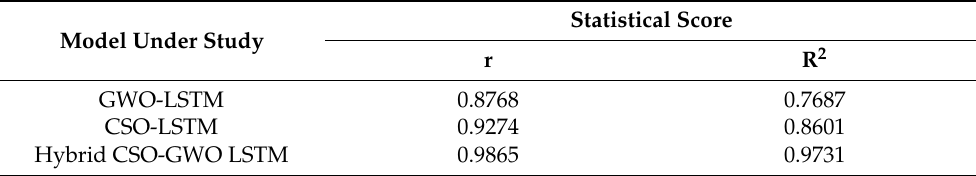
Table 3. Statistical Analysis of the Proposed